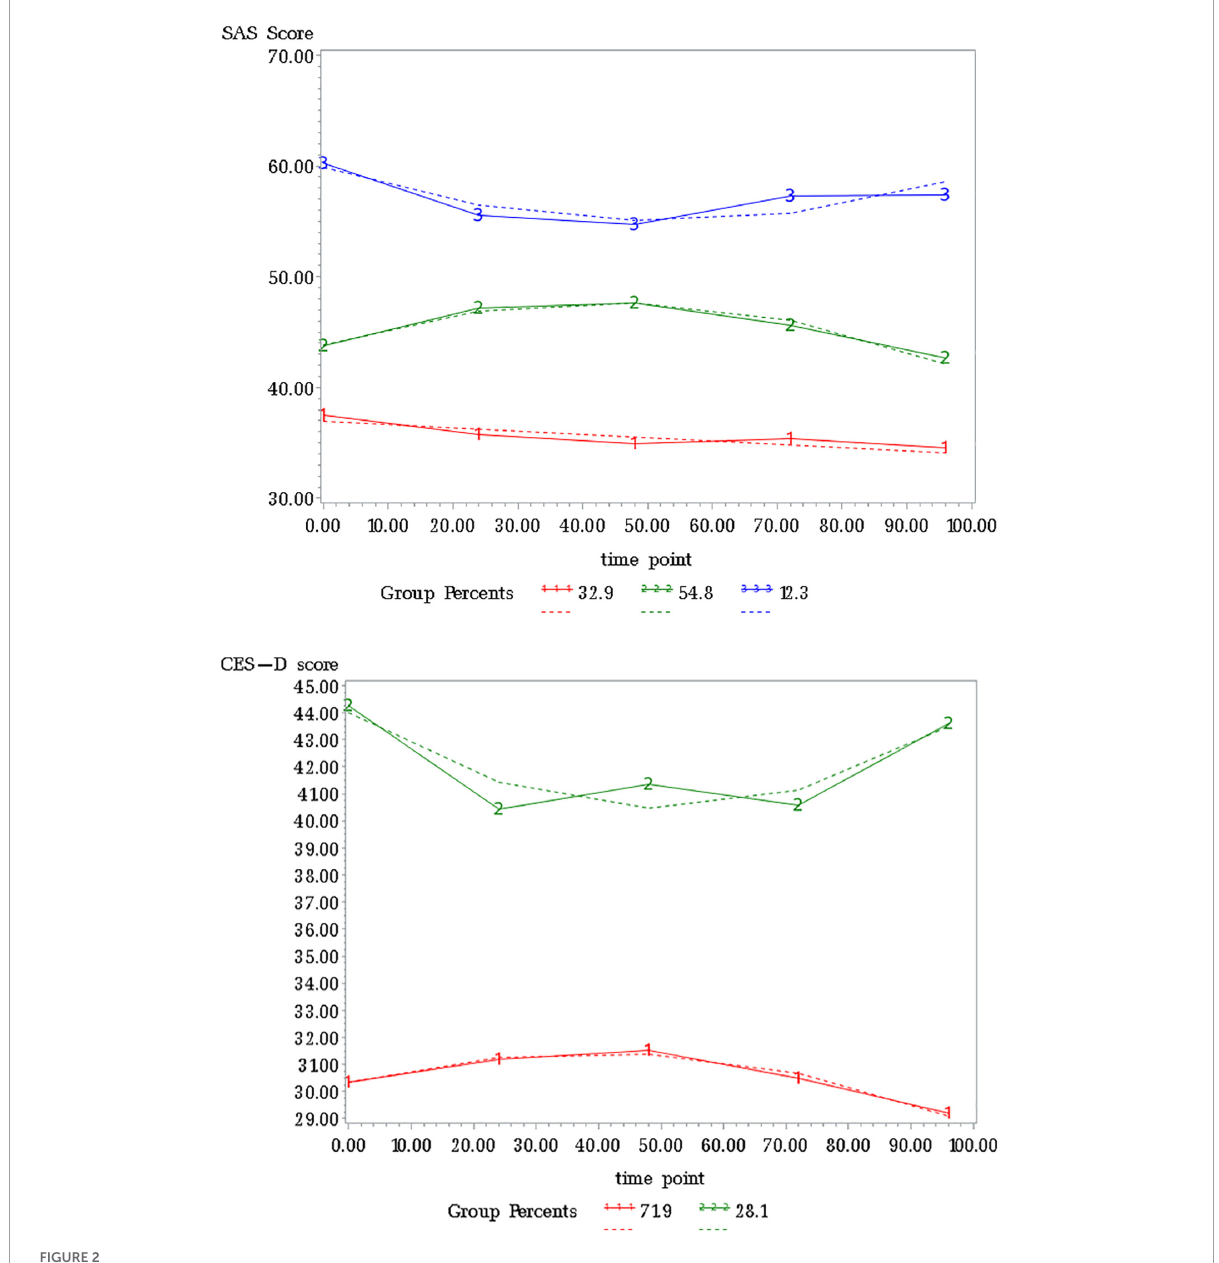
FIGURE2 An optimal trajectory model curve of anxiety and depression.